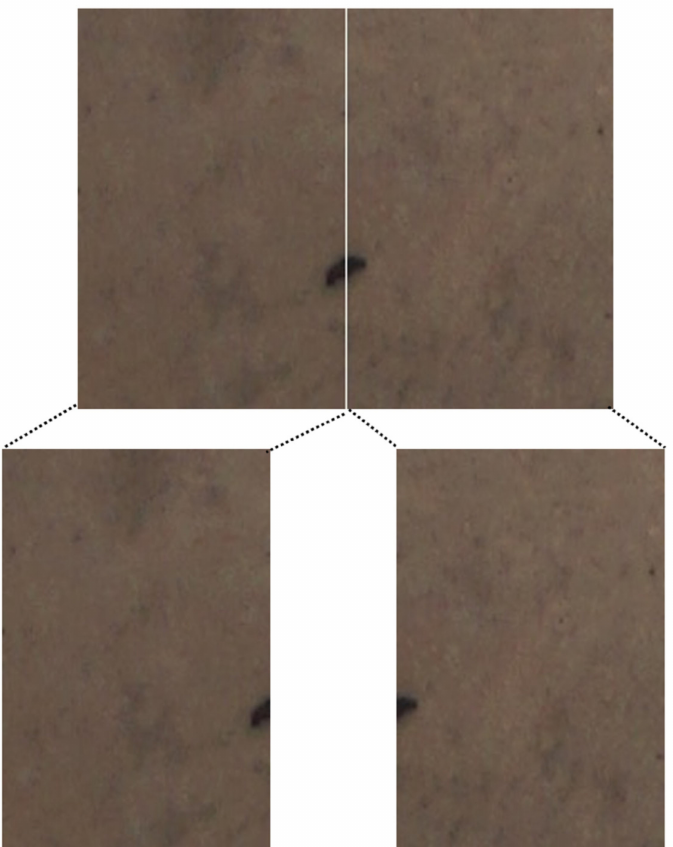
Figure 9. Example diagram of bisection segmentation that may cause false detection or false